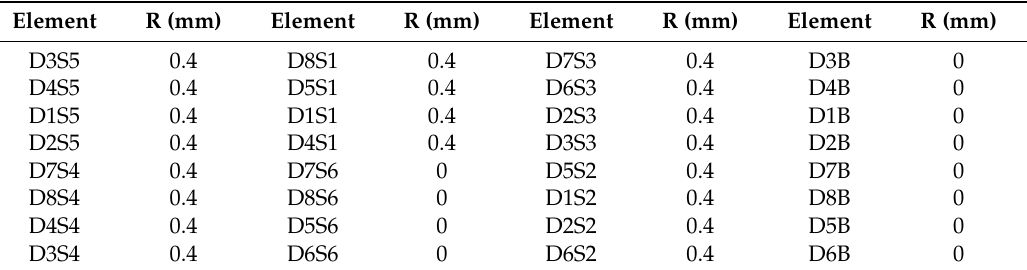
Table 2. Strut element radius represents the optimization result of the ground structure.